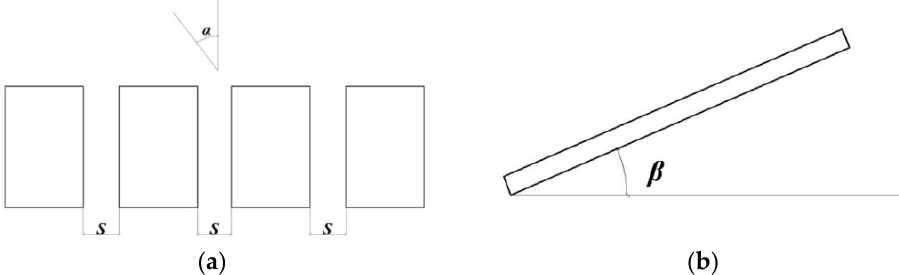
Figure 4. De fi nition of governing parameters in PV system: ( a ) spacing ratio and angle of a tt ack; ( b ) inclination.